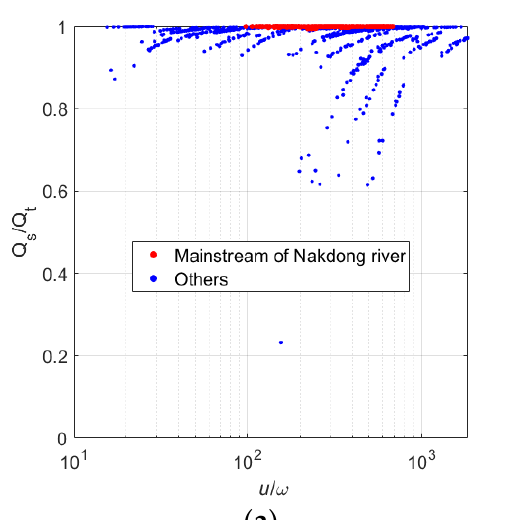
Jang [12] used sediment measurement results obtained from 14 gauging points from